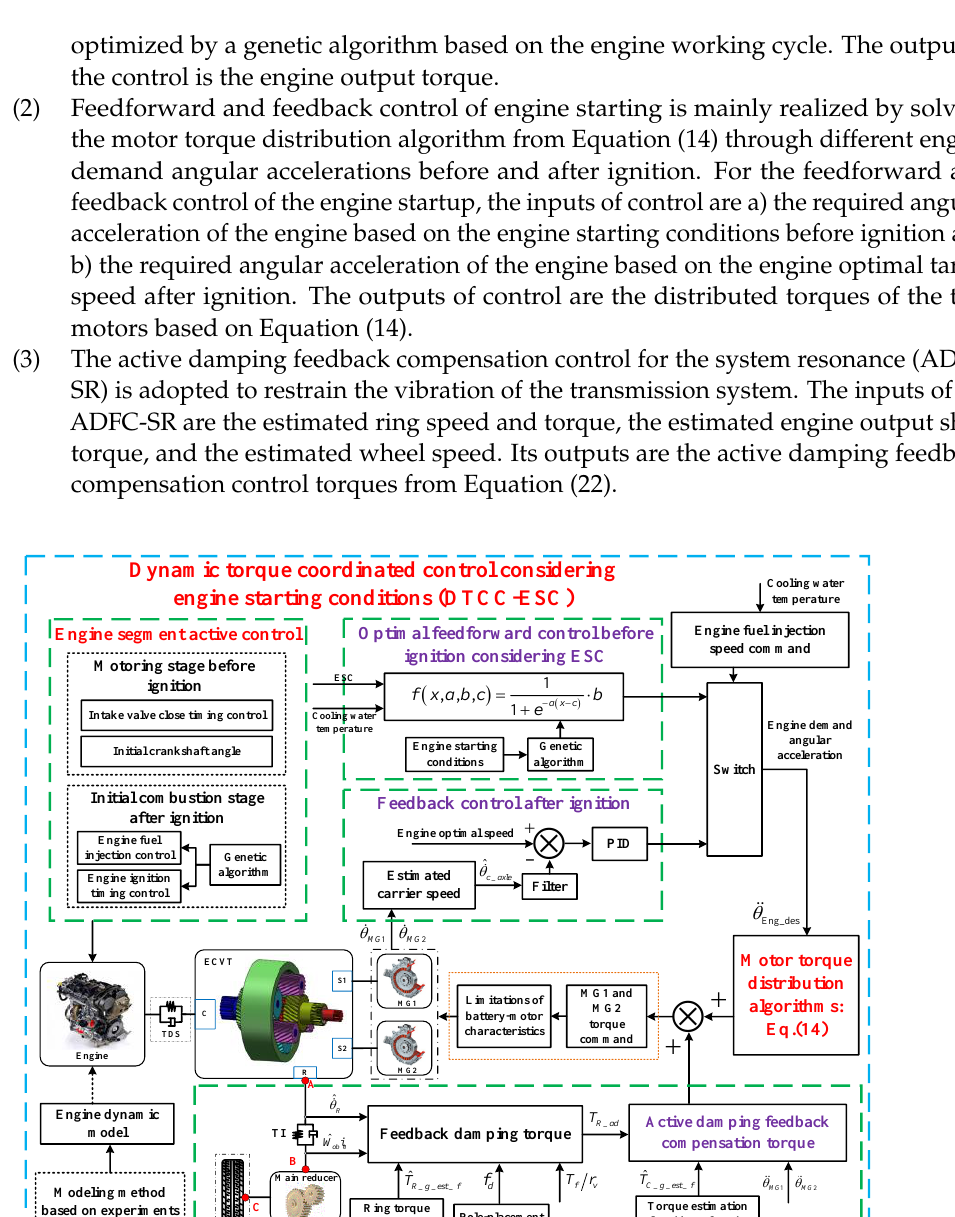
Figure 8. Block diagram of the dynamic torque coordinated control strategy.